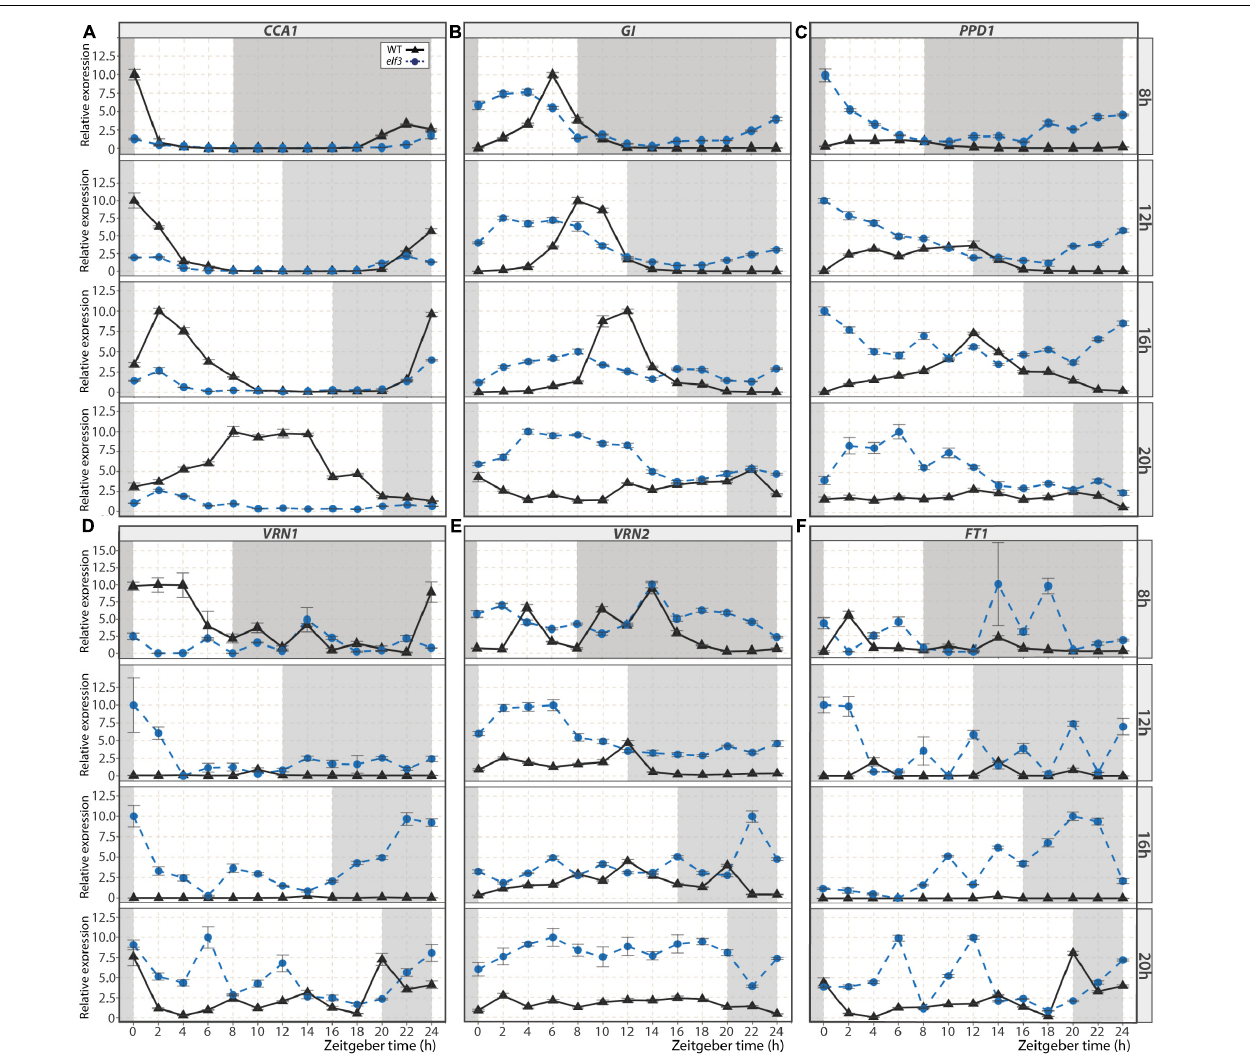
FIGURE 3 | Expression kinetics of selected genes in the elf3 mutant. Relative expression of circadian clock-regulated genes CCA1 (A) , GI (B) , PPD1 (C) , and the flowering genes VRN1 (D) , VRN2 (E) , and FT1 (F) during a 24 h time course for WT plants (black triangles) and elf3 mutants (blue circle) cultivated under 8, 12, 16, and 20 h photoperiods. Error bars represent the standard error of the mean. Data were normalized using the geometric mean of ACT3 and UBC18 . The white background indicates the light period, and the gray background shows the dark period. Time is expressed as the number of hours following the start of the light period (Zeitgeber time,